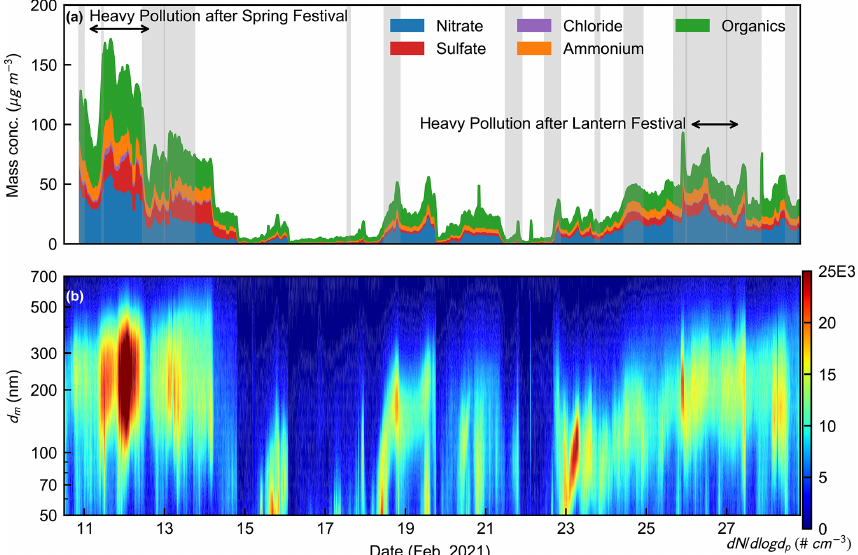
Figure 2. Time series of (a) nonrefractory PM 1 mass concentration and (b) particle number size distribution. The grey shading and black arrows in (a) indicate IN experiment time periods and heavy pollution after celebrations, respectively.